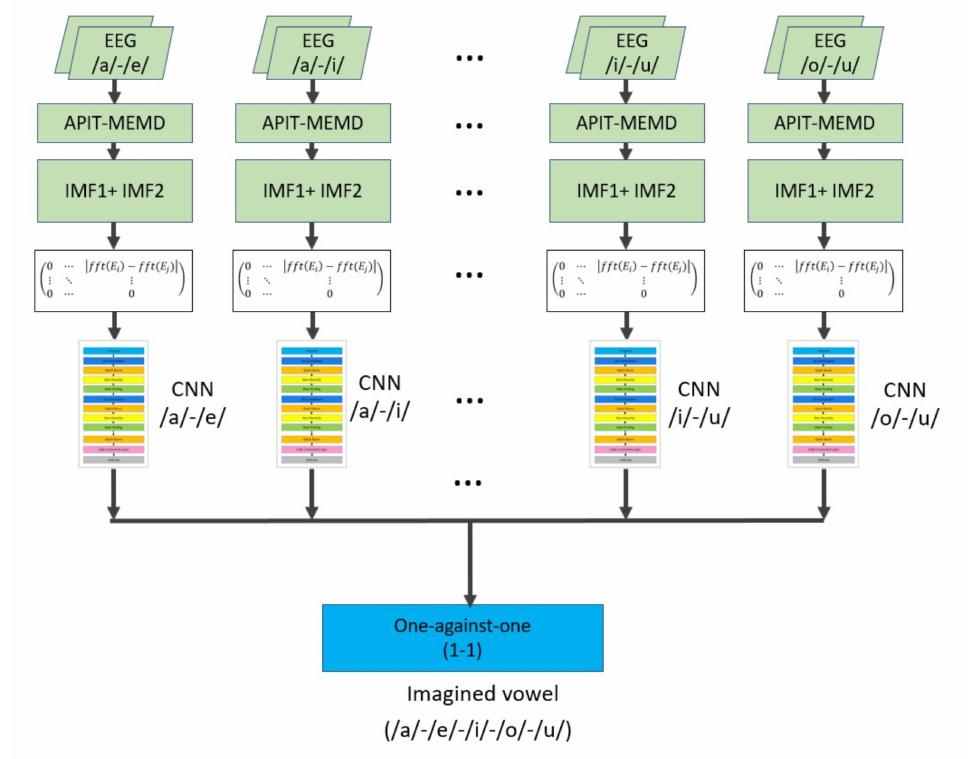
Figure 4. CNNeeg1-1 architecture made up of 10 specialized CNNs and a one-against-one function. The input layer for each CNN receives the information of the images obtained from the EEG imagined vowels. It consists of a tensor of size 32 × 15 × 1 for database